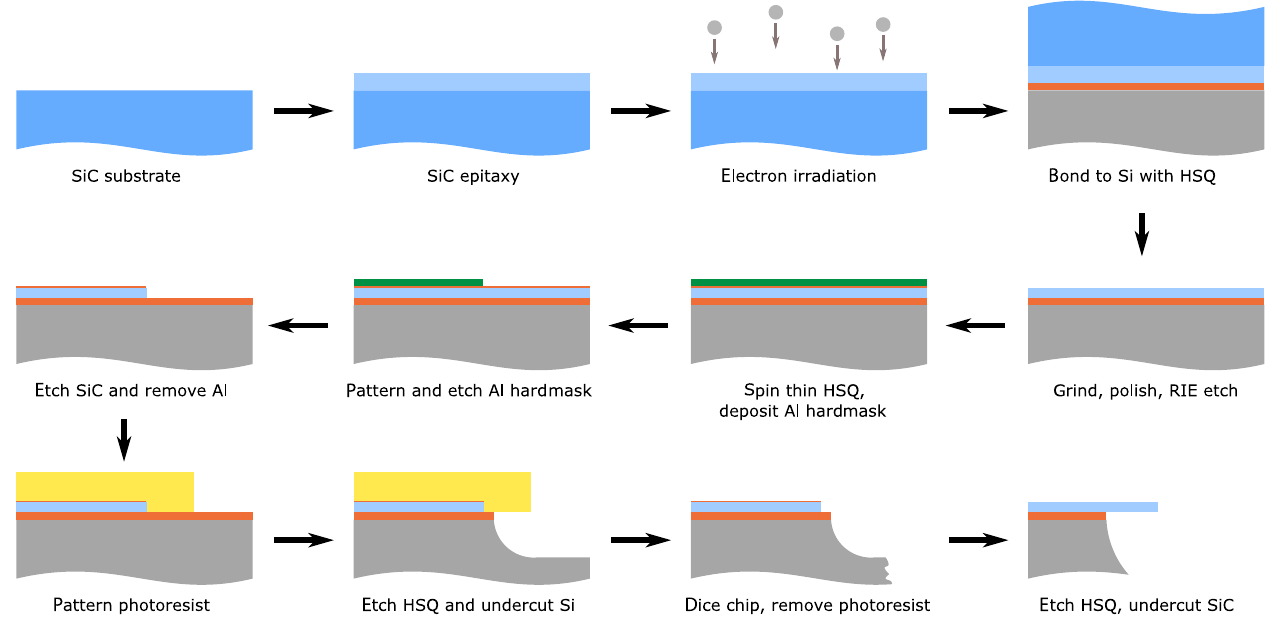
FIG. 6. Device fabrication process flow. Colors correspond to materials as follows: blue, SiC substrate; light blue, SiC epitaxy; gray, Si substrate; orange, HSQ; green, hardmask; yellow,